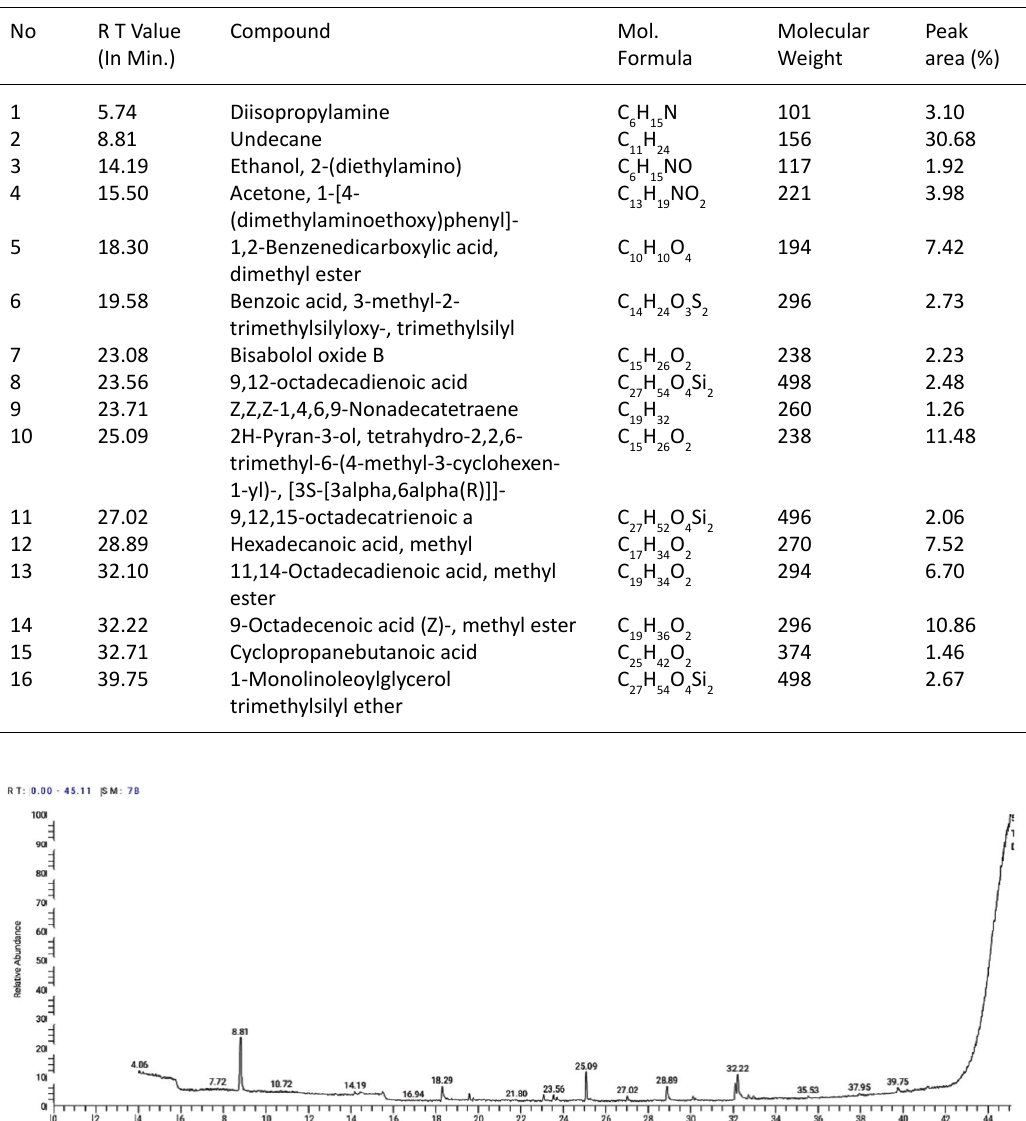
Table 6. Components detected in Streptomyces mutabilis M3 MT483919 crude extract No